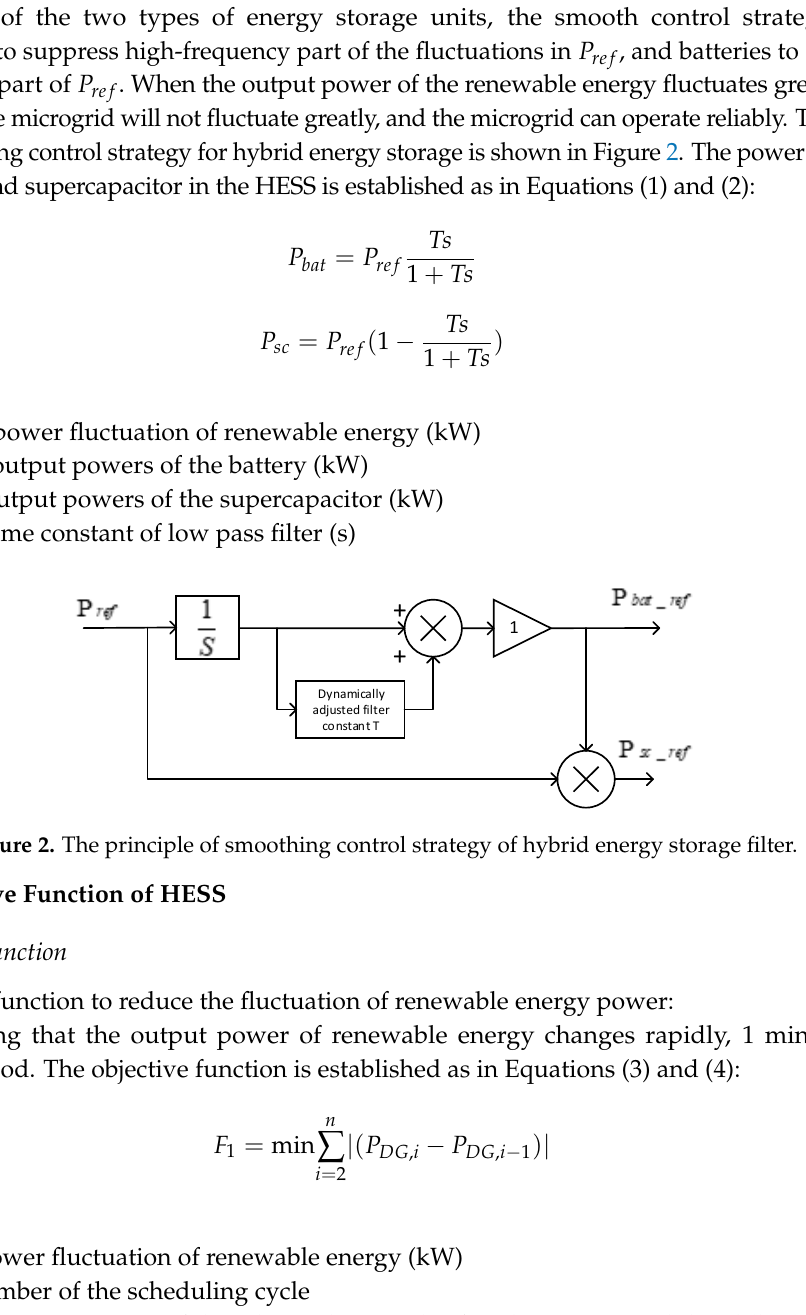
Figure 1. System Structure.